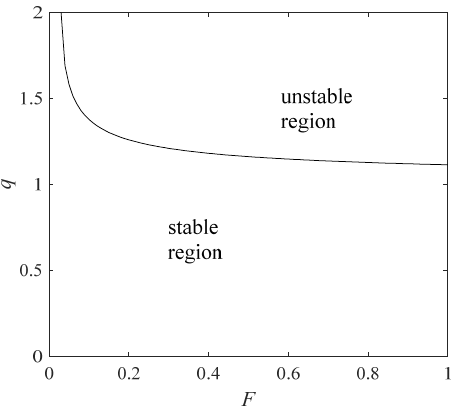
(cid:16) ±√ (cid:17)   ,0 F  . F ,0